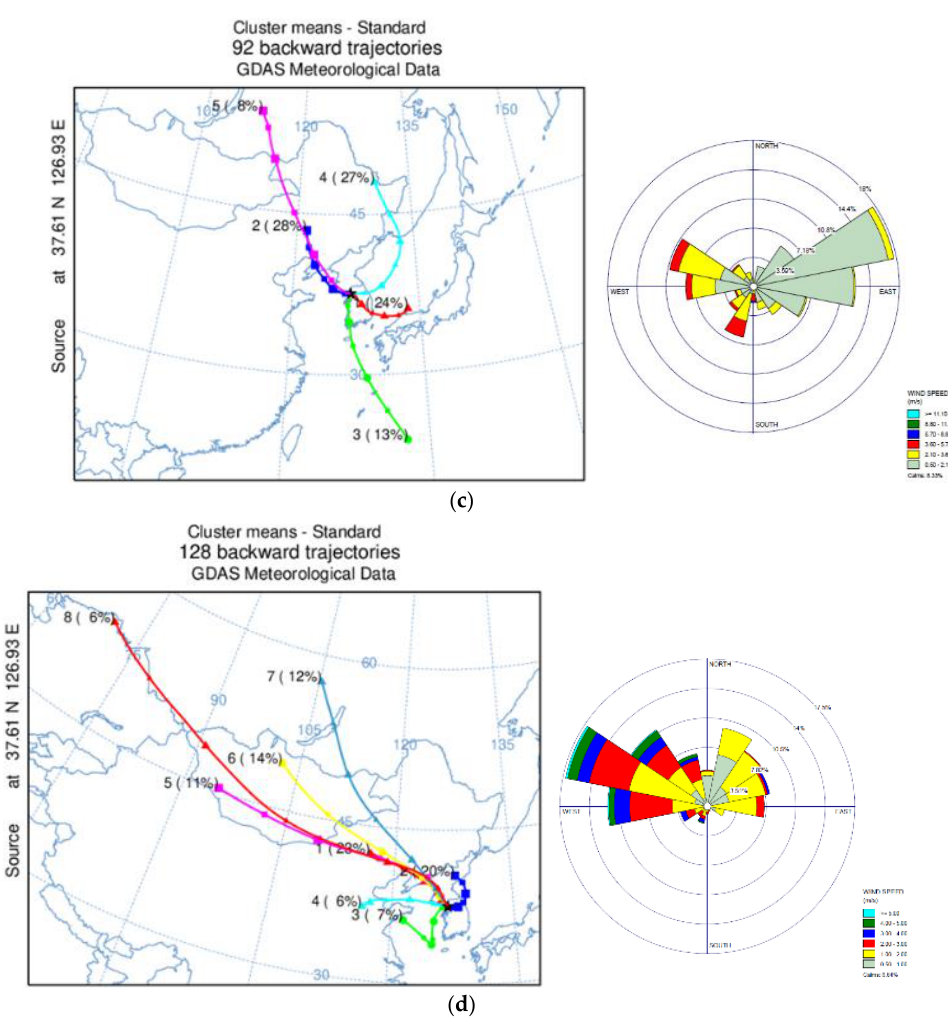
Figure 8. Seasonal back trajectory cluster analysis performed with HYSPLIT and averaged wind direction and speed analysis performed with WINDROSE. ( a ) Winter; ( b ) Spring; ( c ) Summer; ( d ) Fall.